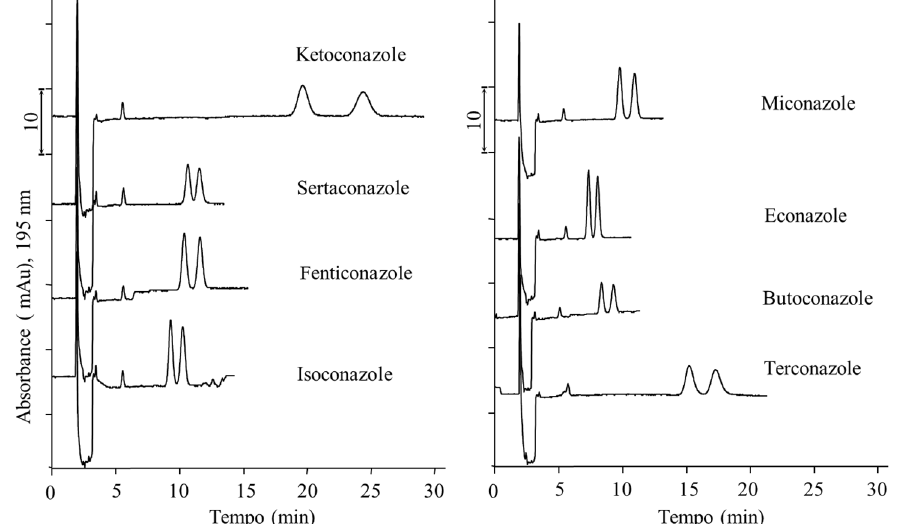
Figure 4. Nano-LC enantioseparation of the studied antifungal drugs. Chromatographic conditions: 20 mM ammonium hydrogen carbonate (pH 9) in ACN/water (85/15, v / v ); flow rate: 400 nL min − 1 ; injection volume: 300 nL; sample concentration (racemic): 10 µg mL − 1 . For other experimental conditions, see Figure 1 and text.